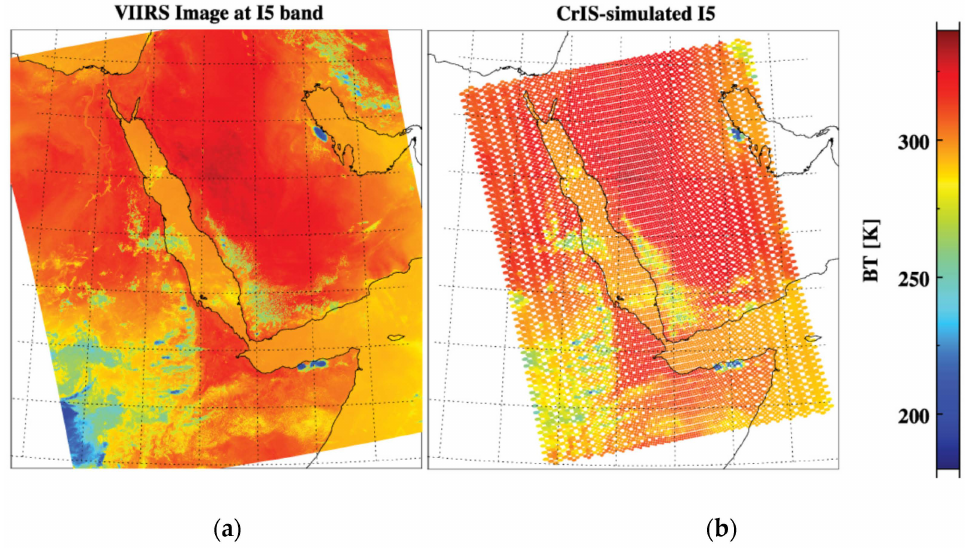
Figure 2. Examples of VIIRS I5 ( a ) and CrIS ( b ) images from 1024UTC to 1032UTC on 5 September 2015. The CrIS spectra have been convolved with VIIRS spectral response function to match VIIRS I5 band radiances.